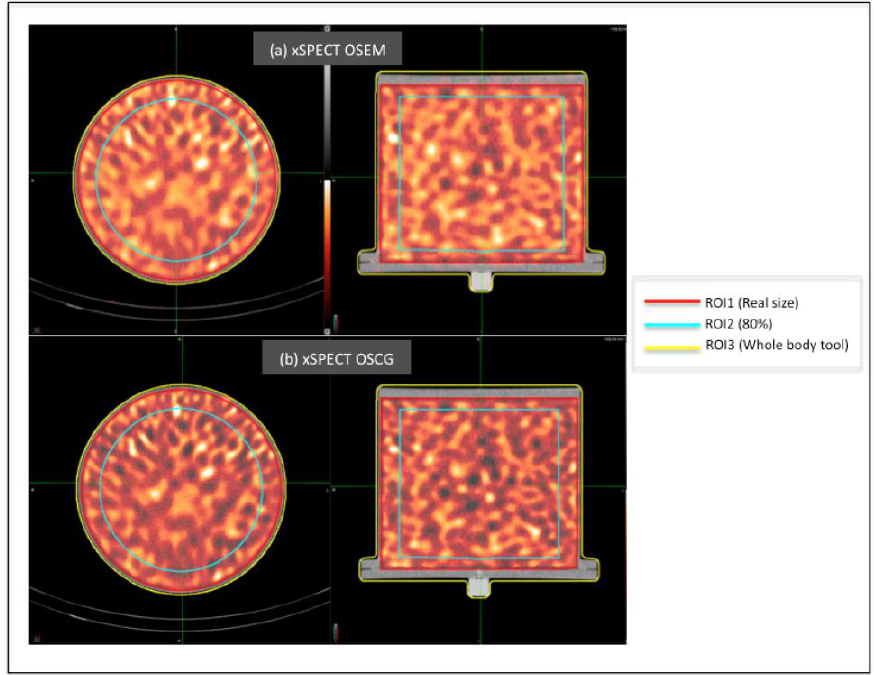
Figure 6. Data reconstructed with ( a ) OSEM and ( b ) OSCG algorithm in xSPECT system for the homogeneous phantom.